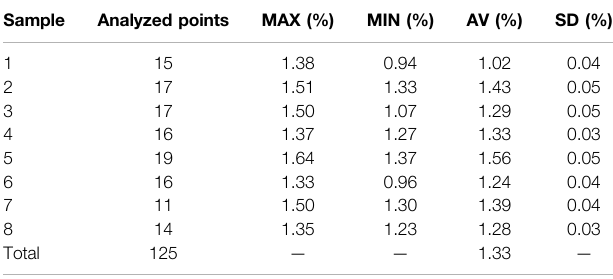
TABLE 1 | Re fl ectance data of the charcoali fi ed Germaropteris martinsii leaves from the upper Permian Kayitou Formation of Southwest China. Sample Analyzed